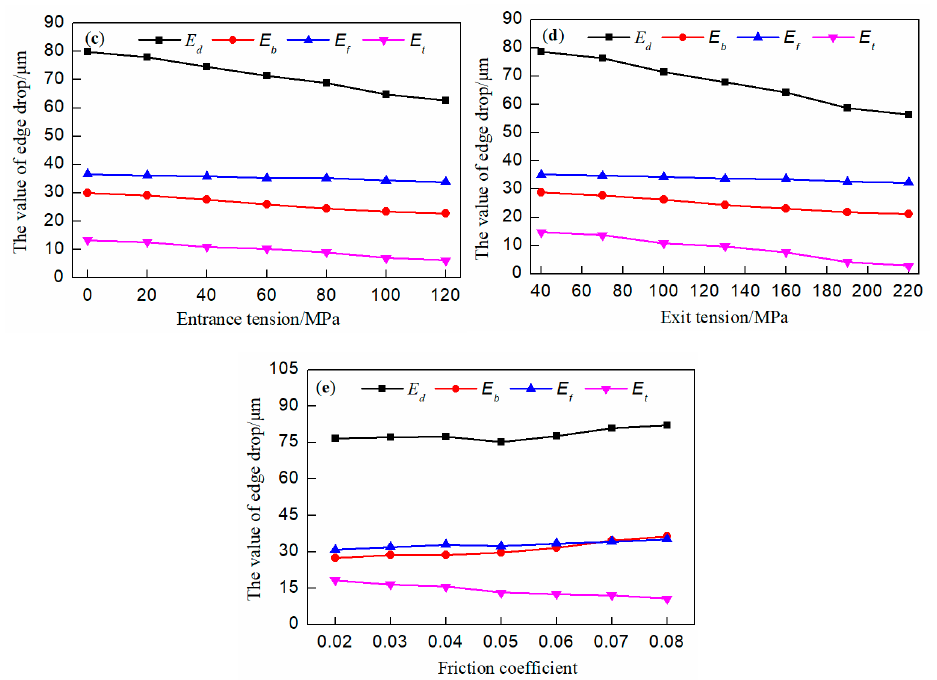
Figure 9. The effect of process parameters on edge drop: ( a ) Entrance thickness; ( b ) rolling reduction; ( c ) entrance tension; ( d ) exit tension; and ( e ) friction coefficient.